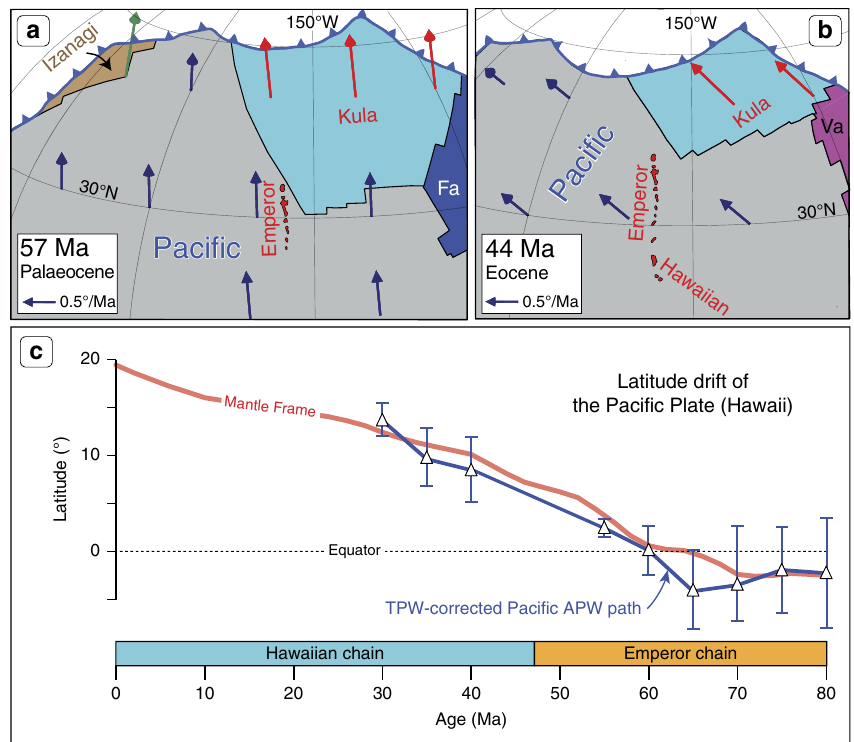
Figure 7 | Plate reconstructions and latitudes. ( a , b ) Absolute North Pacific plate reconstructions and plate velocity vectors 28 before and after the time of the Hawaiian-Emperor bend. The Kula plate formed at B 83Ma from pieces of the Izanagi, Farallon (Fa), and Pacific plates 26,57 , and was subducted at B 40Ma. The Izanagi plate was subducted at B 55Ma, while the Vancouver (Va) plate formed at B 52Ma. ( c ) Latitudinal motion of a location on the Pacific plate, which is presently at the position of Hawaii (19.4 (cid:2) N, 155.2 (cid:2) W), calculated using the Doubrovine et al. 28 model of the Pacific absolute plate motion (red line labelled ‘Mantle Frame’) and the Pacific APW path (Fig. 8b) corrected for TPW (white triangles with 95% confidence bars, connected with blue lines; see Methods and Table